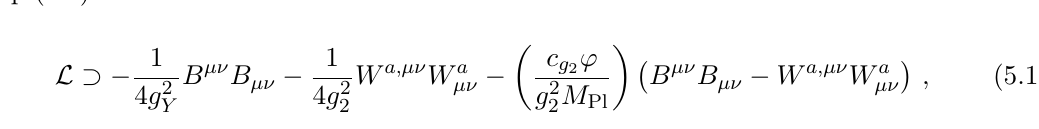
Figure 7 . Left : contours of constant (cid:14)(cid:11) 2 for varying scalar mass and DM fraction f DM . The blue shaded region is excluded by CMB and large-scale structure (LSS) data [93], while the dashed black line corresponds (cid:11) 2 ! 1 , with (cid:11) 2 < 0 above. The scalar coupling has been set to c g the variation in the weak coupling (cid:14)(cid:11) 2 as a function of the mass for di(cid:11)erent choices of the scalar couplings c g . The DM fraction has been set to f DM = 0 : 025 to be free of CMB/LSS constraints. 2 We allow large c g by enforcing c e = 0 as discussed in the 2